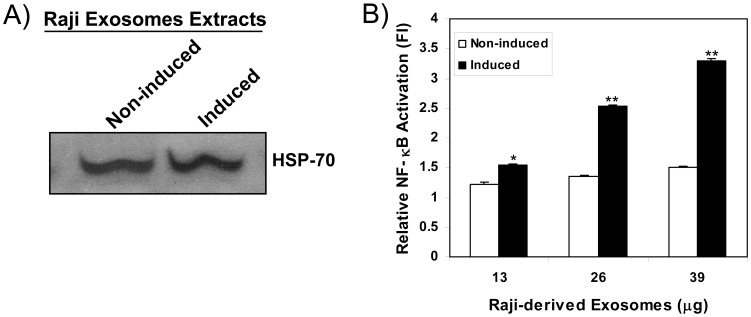
EBV-encoded dUTPase released in exosomes induces NF-κB activation through TLR2.A) Western blot analysis of exosomal marker HSP-70 in extracts from non-induced and induced Raji cells-derived exosomes. B) TLR2-HEK293 expressing cells were transiently transfected with NF-κB reporter gene and pRL-TK transfection control plasmids. After 24–36 h, cells were exposed for 8 h to equal amounts of exosome extracts (13–39 µg) from induced or non-induced Raji cells and luciferase reporter activity measured, as we have described [12]. Data was normalized for transfection efficiency and reporter activity expressed as the mean relative stimulation ± SD of an n = 4. *p<0.05, **p<0.01.